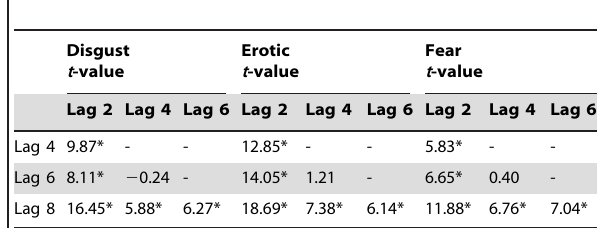
Table 2. Comparison between emotional blink magnitude scores at each